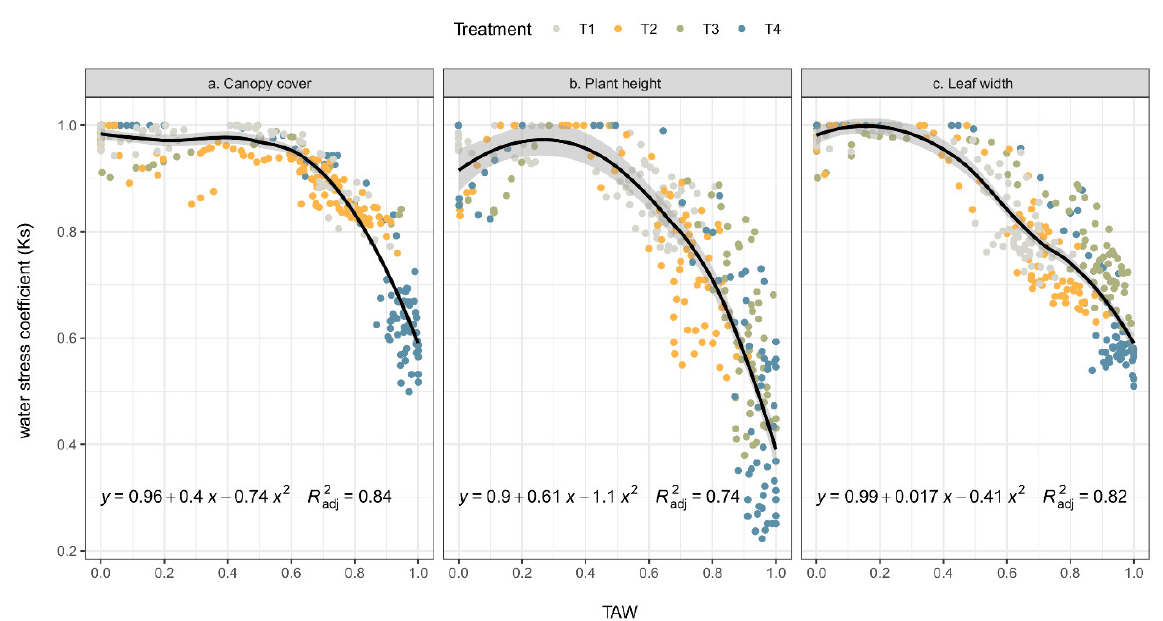
Figure 6. Scattergram of the water stress coefficient ( Ks ) for each response variable: ( a ) canopy cover ( b ) plant height ( c ) leaf width during a stress cycle ryegrass ( Lolium perenne ). Treatment are color coded. T1: moderate–low water stress treatment (grey color), T2: moderate–high water stress treatment (yellow color), T3: medium intensity severe water stress treatment (green color), T4: high intensity severe water stress treatment (blue color).